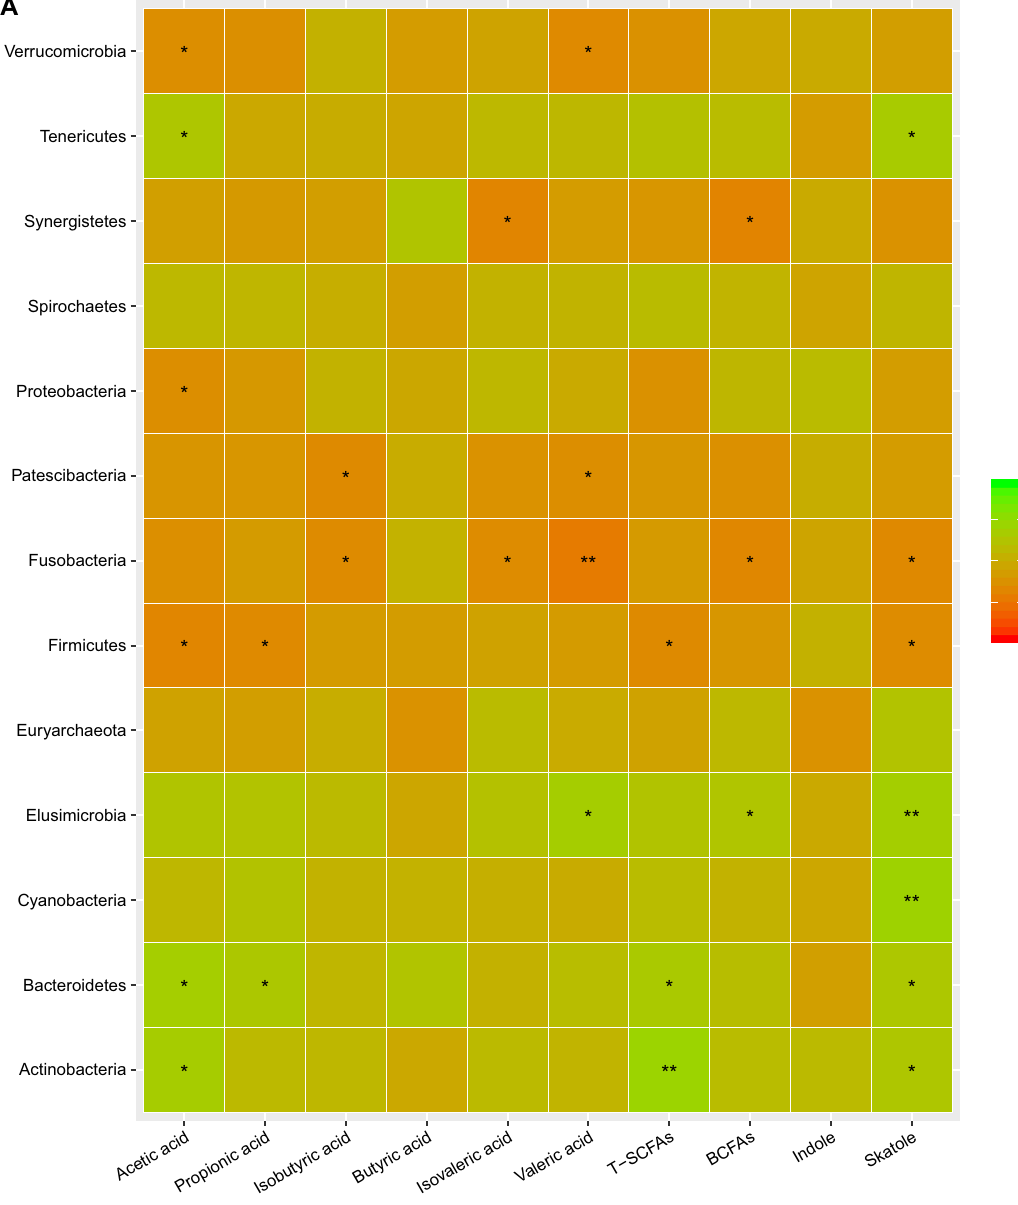
Figure 5. Abundance of the gut microbiota was significantly associated with levels of metabolites. ( A ) at the phyla level; ( B ) at the genus level. Green color represents positive correlation and red color represents negative correlation. Correlation was considered significant when the absolute value of Spearman’s rank correlation coefficient (Spearman’s r) was > 0.6 and statistically significant ( P < 0.05). The asterisks indicate significant correlation, * P < 0.05; ** P < 0.01; *** P <